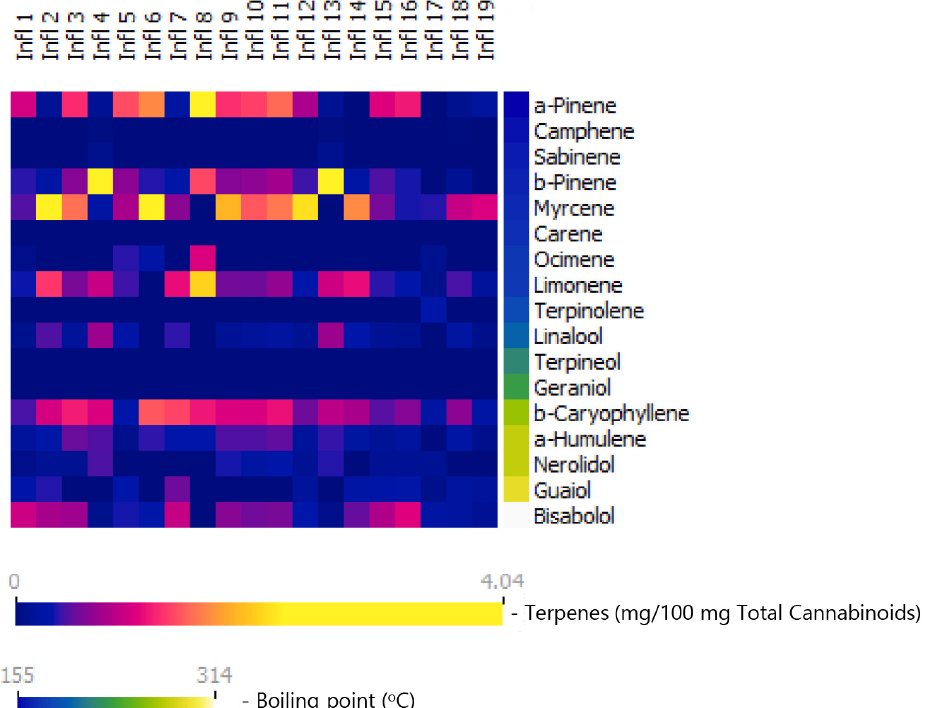
Figure 1. Terpene content in nineteen commercial cannabis inflorescences marketed in Israel, pre- sented as milligrams of each terpene per 100 mg total cannabinoid content. Terpenes are arranged according to their boiling points. As seen, monoterpenes comprise the largest terpene group in these inflorescences. Furthermore, the diversity between inflorescences is driven, to a large extent by